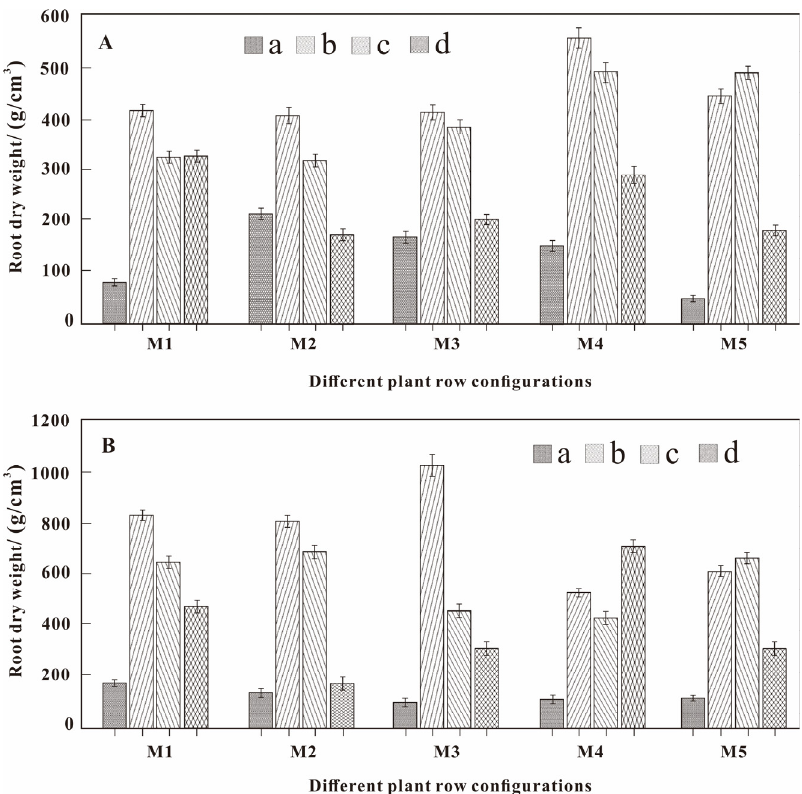
Figure 5. Distribution characteristics of root dry weight density at different growth stages. (a: Over- wintering, b: jointing, c: heading, d: ripening). ( A ) Multi-spike wheat. ( B ) Large-spike wheat.